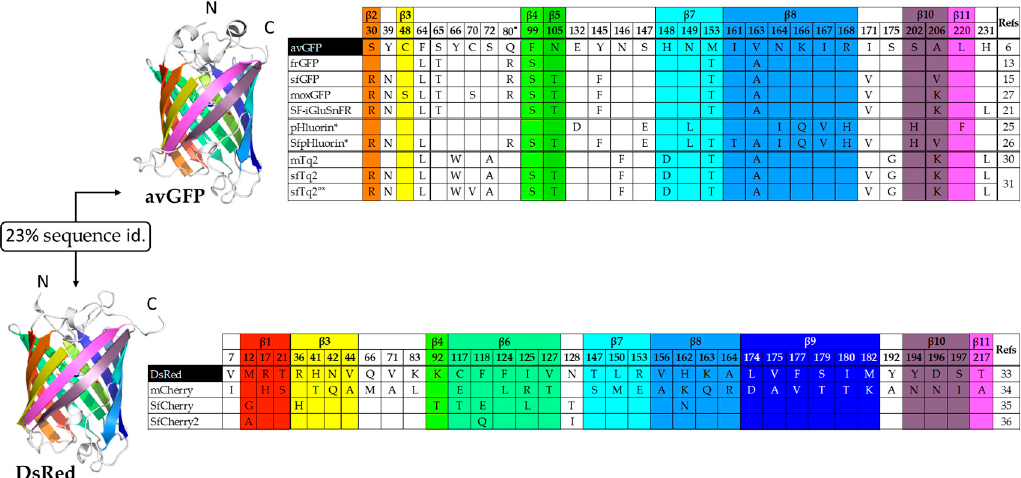
Figure 1. Superfolder variants of (top) green fluorescent protein (GFP) and (bottom) DsRed. The β -can structures of GFP (PDB code 1ema) and DsRed (PDB code 1g7k) share ~23% sequence identity. Strands β 1 to β 11 are colored from dark red to magenta in the ribbon structures and corresponding tables. Mutations refer to A. victoria GFP (avGFP) and DsRed indicated on a black background. The asterisk (*) refers to the ratiometric pHluorin. ( • ) The Q80R mutation is present in most cDNA constructs and may have resulted from a PCR error [19].